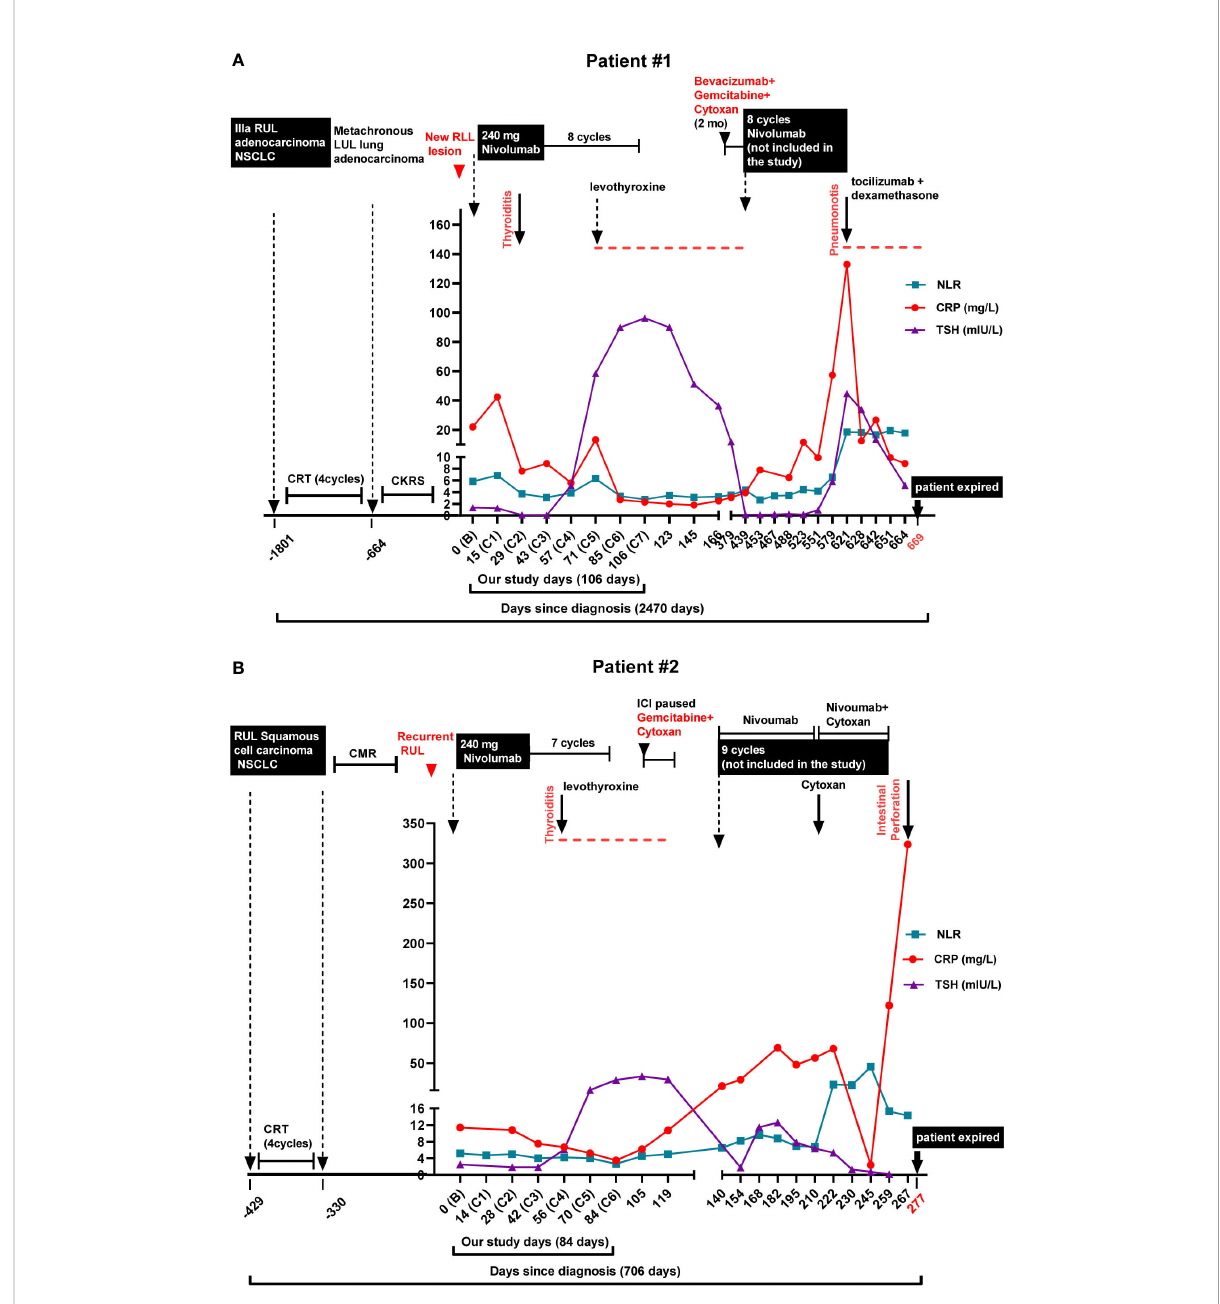
FIGURE 1 Diagnosis, treatment regimens, immune-related adverse events, and biomarker levels in the lung cancer patients. Neutrophile to Lymphocyte Ratio (NLR), C-Reactive Protein (CRP), and Thyroid Stimulating Hormone (TSH) levels are shown along with the treatment and immune-related adverse events (irAEs). (A) Patient #1. The patient had a 5-year history (-1801 days) of inoperable stage IIIA (T1aN2M0) right upper lobe (RUL) lung adenocarcinoma. He was initially treated with chemoradiation, followed by disease progression. He then received 8 doses of bi-weekly 240 mg Nivolumab (days 0 to 106) and was enrolled in the biomarker study. Checkpoint inhibitor-induced thyroid dysfunction (CITD, thyroiditis) was observed as an immune-related adverse event (irAE) after the 2 nd dose of Nivolumab (C2). Later, the patient received another round of Nivolumab treatment (days 439 to 621, not enrolled in our biomarker trial) in which pneumonitis as another irAE occurred (day 621). (B) Patient #2. The patient was diagnosed with RUL squamous cell carcinoma (-429 days) and received chemoradiation. Subsequent PET scan demonstrated a complete metabolic response (CMR). Unfortunately, 7 months later he had recurrence of RUL mass. The patient received 7 cycles of bi-weekly 240 mg Nivolumab treatment (days 0 to 84) when enrolled in our biomarker study. CIDT (thyroiditis) was detected after the 4 th dose of Nivolumab (C4). Later, the patient received another round of Nivolumab treatment (days 140 to 259, not enrolled in our biomarker trial) in which another irAE, intestinal perforation, occurred (day